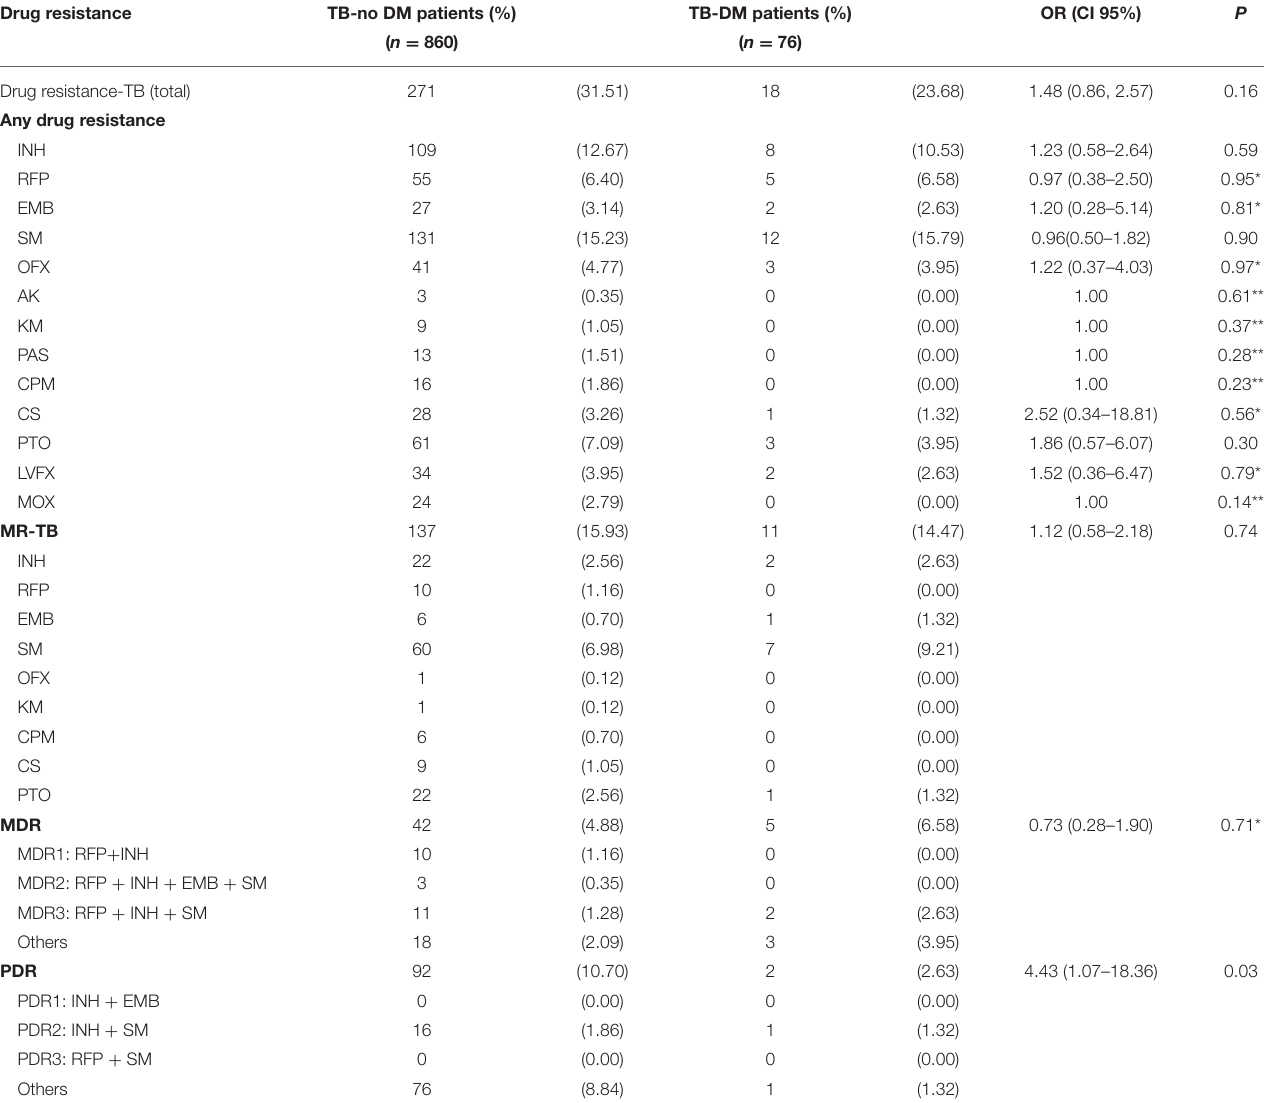
TABLE 2 | Drug-resistance profile of diagnosed tuberculosis (TB) cases with and without diabetes mellitus (DM). Drug resistance TB-no DM patients (%) TB-DM patients (%) OR (CI